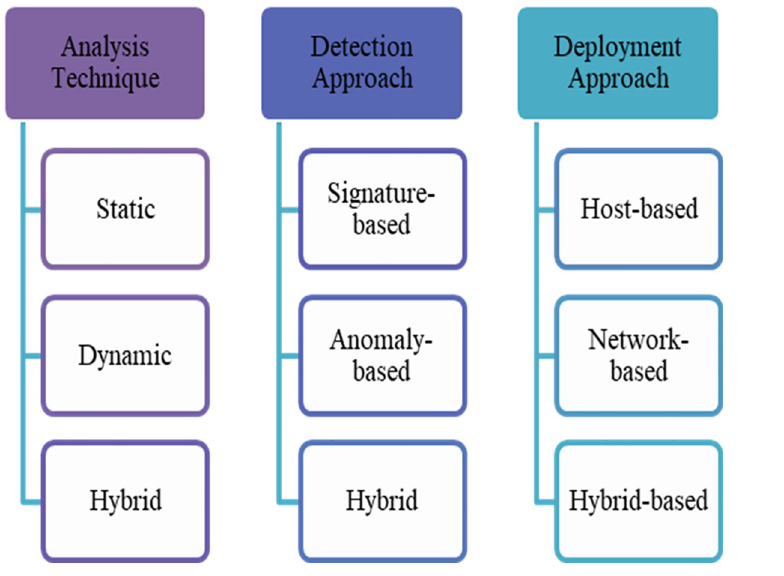
Fig 3. Taxonomy of malware intrusion detection systems.